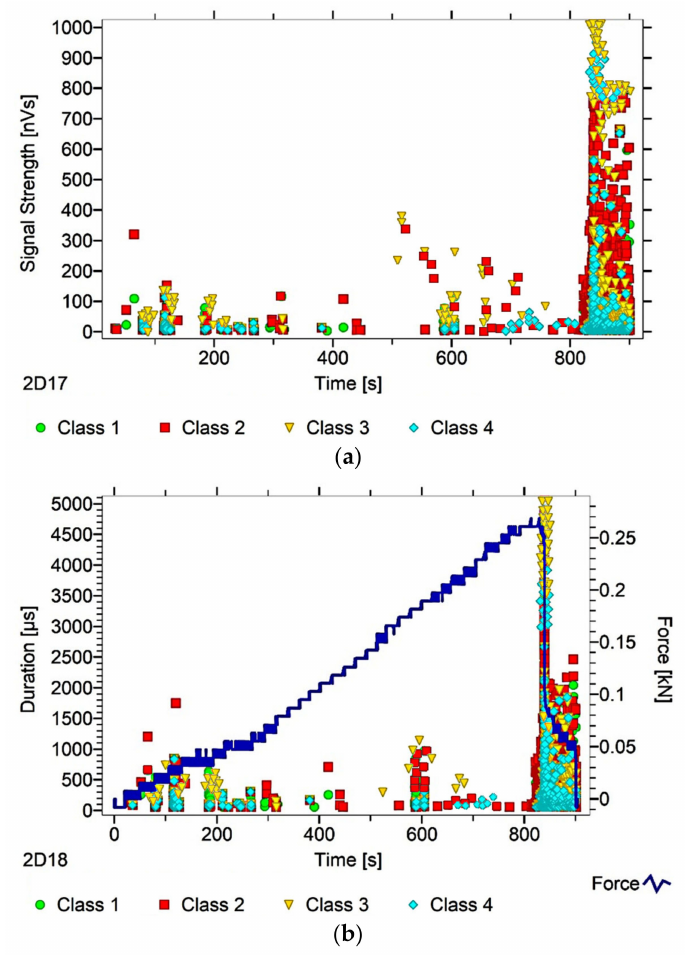
Figure 5. AE signal graphs for the mock BM sample: ( a ) signal strength distribution in time; ( b ) signal duration distribution in time, with plotted force increment